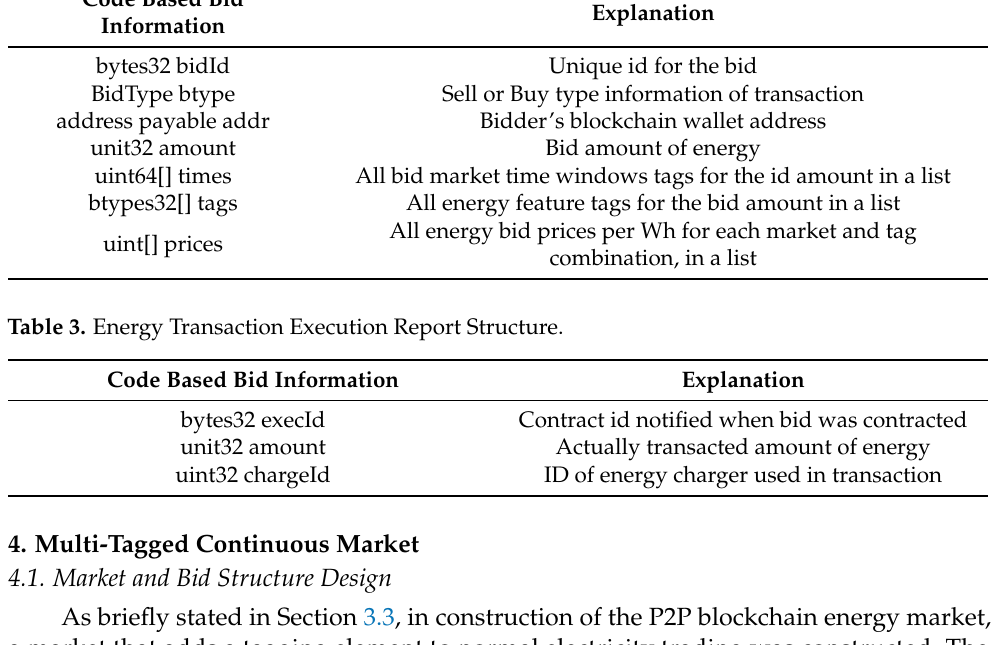
Table 2. Bid Structure.